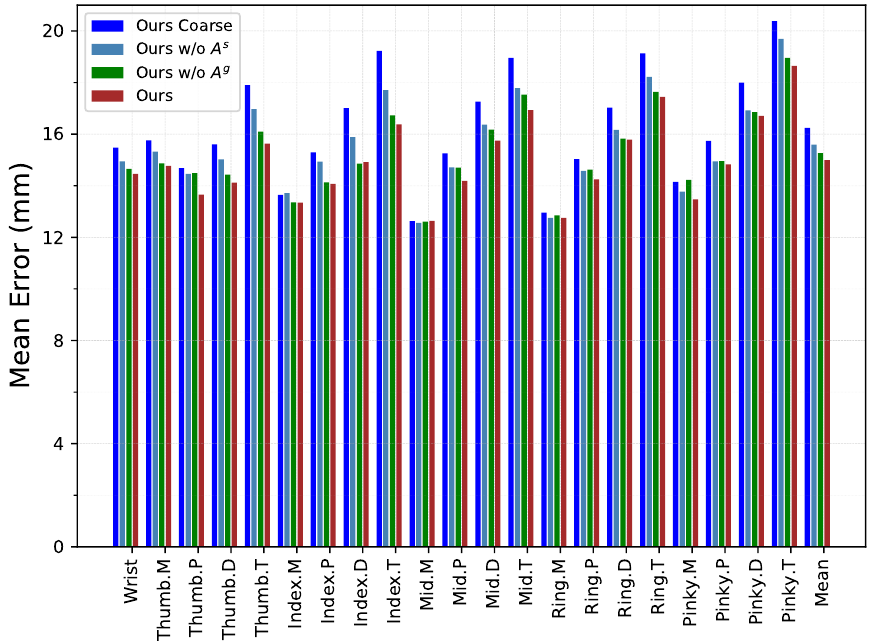
Figure 5. Three-dimensional distance error per hand joints. Note that M, P, and D denote the 3 consecutive joints located between the wrist and fingertip (T) on each finger, in their order.